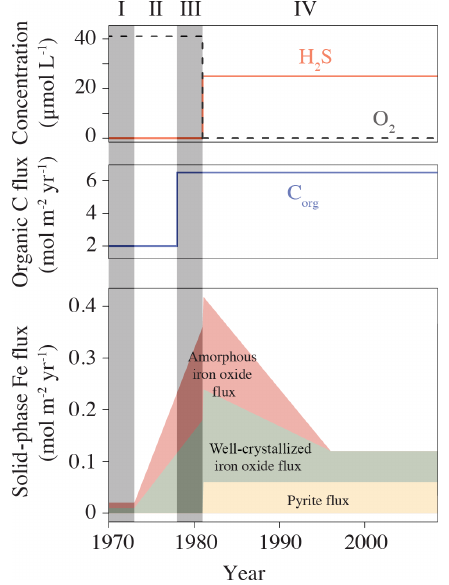
Figure 2. Variability in bottom water redox conditions, organic carbon, and Fe inputs between 1970 and 2009, used to force the reactive-transport model at site F80. Numbers indicate the four dif- ferent time intervals recognized in this study: (I) baseline (1970– 1973), (II) start of change in Fe loading (1973–1978), (III) eutroph- ication but pre-euxinia (1978–1981), and (IV) eutrophication and euxinia (1981–2009). Figure modified from Reed et al.